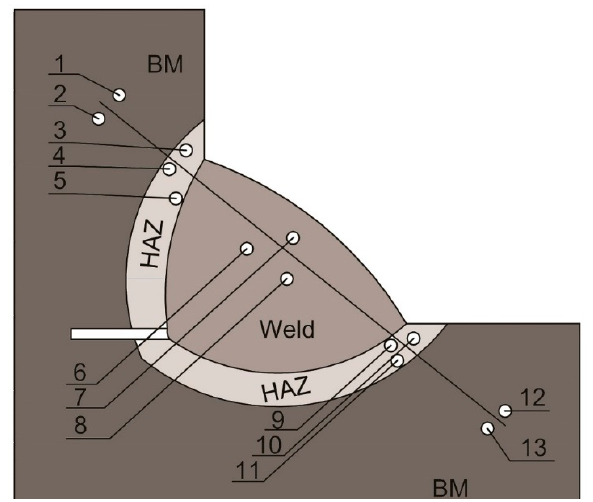
Figure 2. Hardness point distribution in the CTS specimens.